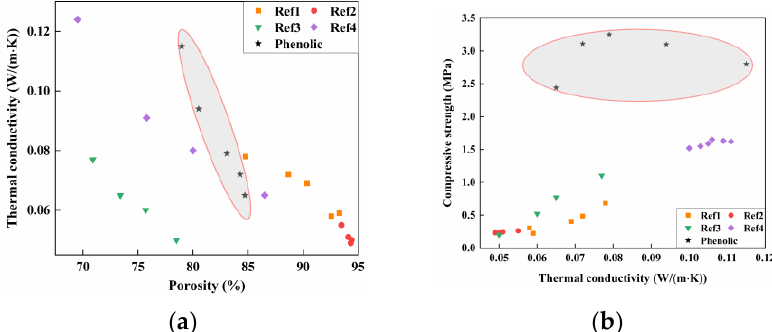
Figure 11. Mechanism analysis of phenolic-foamed concrete: ( a ) the relationship between porosity and thermal conductivity; ( b ) the relationship between thermal conductivity and compressive strength.